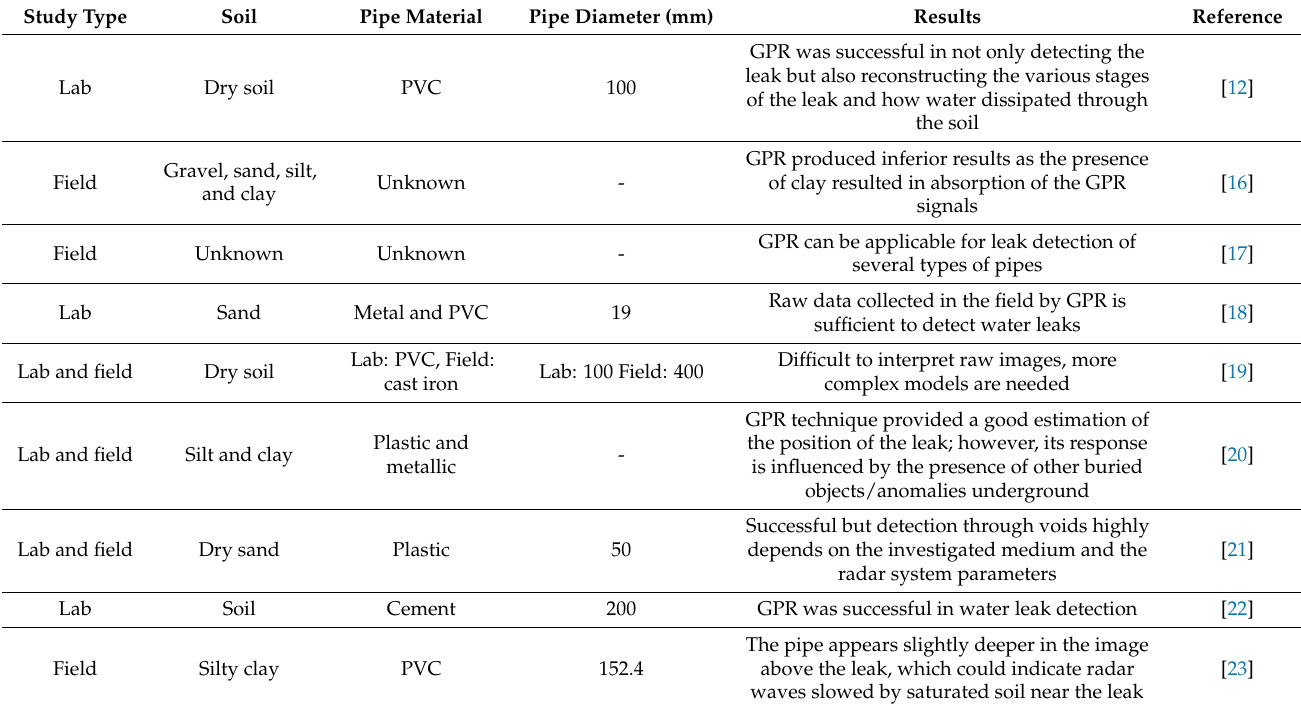
Table 2. Studies using GPR for water leak